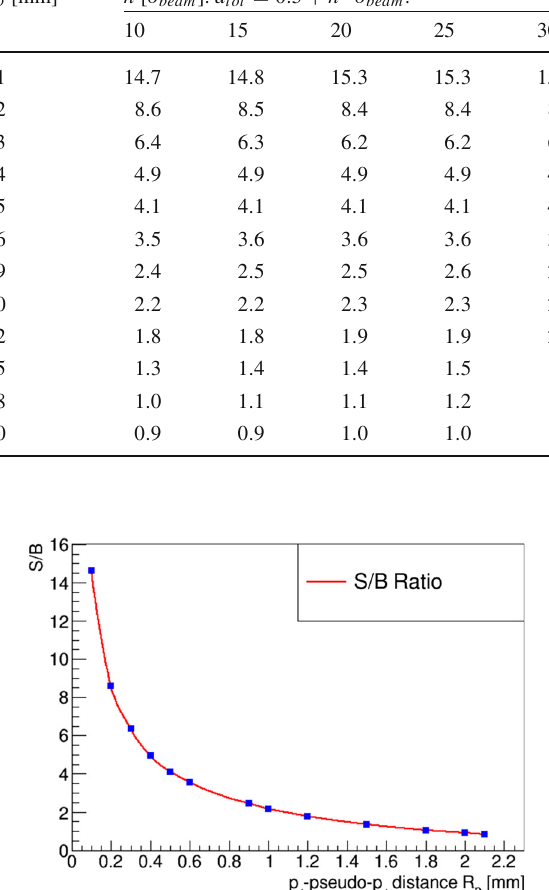
Table 3 The signal to background ratio as a function of R p and d tot = 0 . 5 + n · σ beam for the LHC running with β ∗ = 90 m R p [mm]